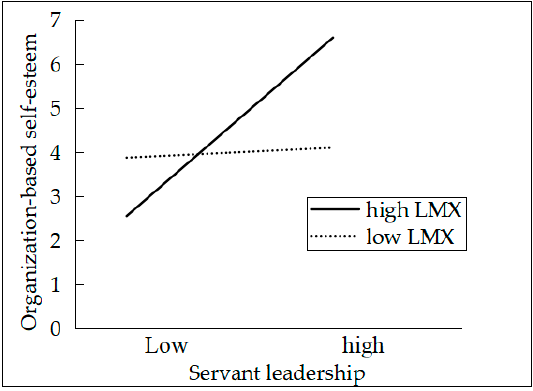
Figure 3. The interaction between servant leadership and LMX on OBSE.